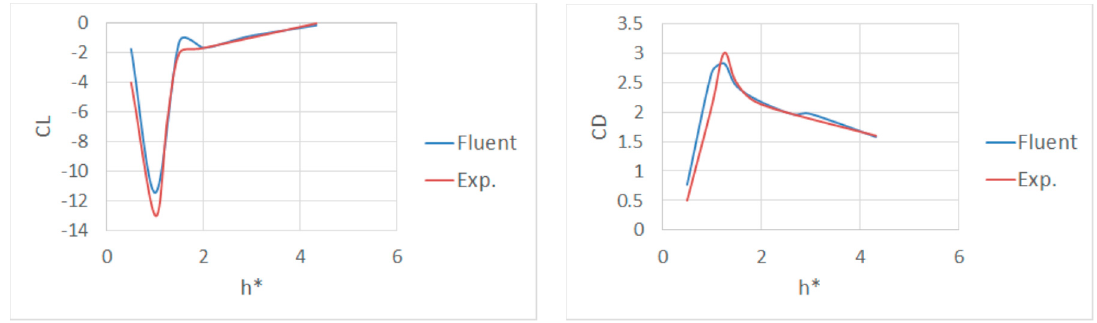
Figure 16. Comparison of numerical and experimental results in terms of force coefficients on the submerged rectangular cylinder.